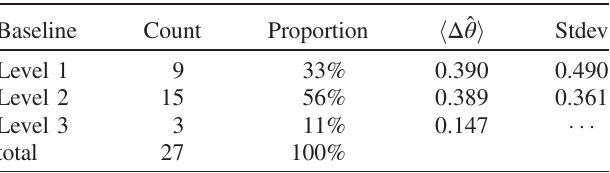
TABLE XI. Baseline distribution and average learning gains of the sample in field testing. Baseline ¼ ability category before instruction; Level 1, Level 2, and Level 3 ¼ 1 -logit long